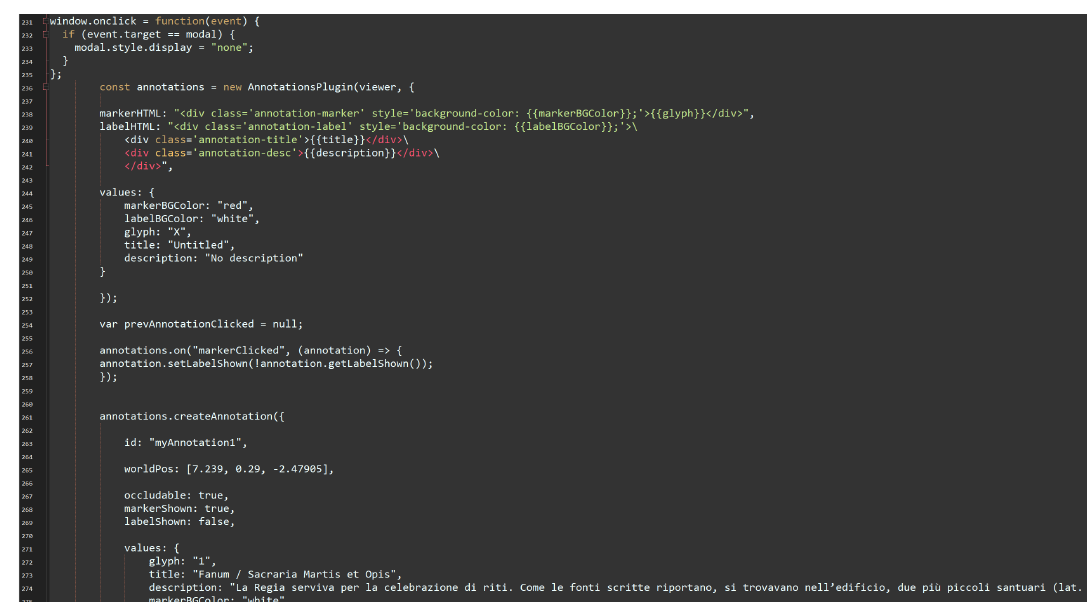
Figure 14. Part of source code related to the Hotspot Model plugin (the complete code is on the ARK-BIM website).